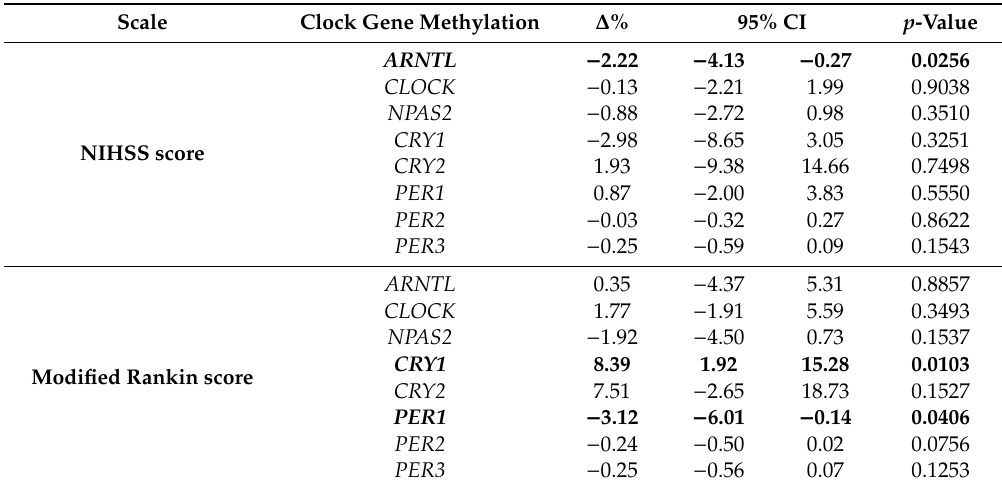
Table 3. Association between clock gene methylation and NIH stroke scale (NIHSS) score and Modified Rankin Scale for Neurological Disability